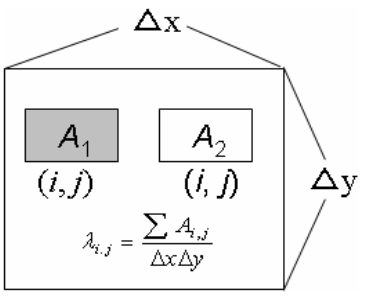
Fig. 2. Concept of buildings sharing ( A 1 ) and ( A 2 ) in each grid.